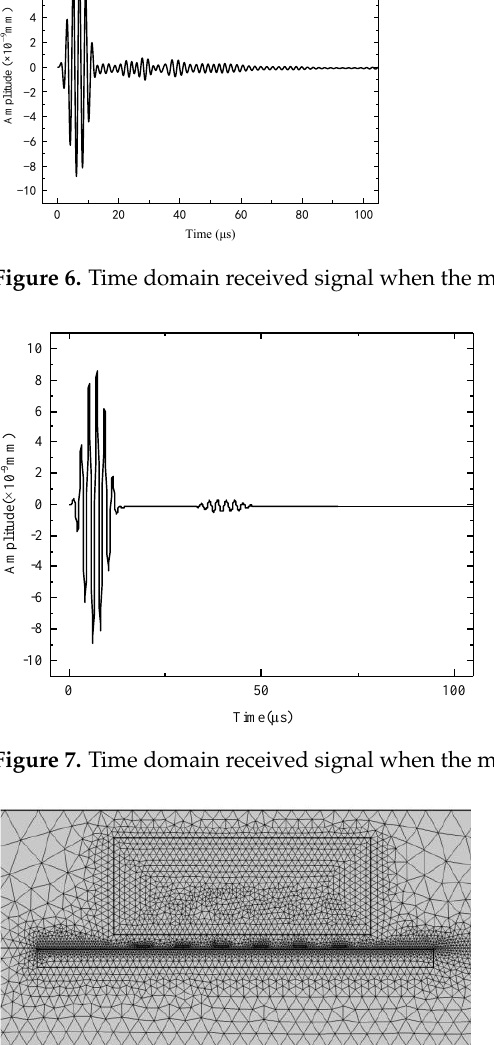
Fig. 7 Meshing of the model